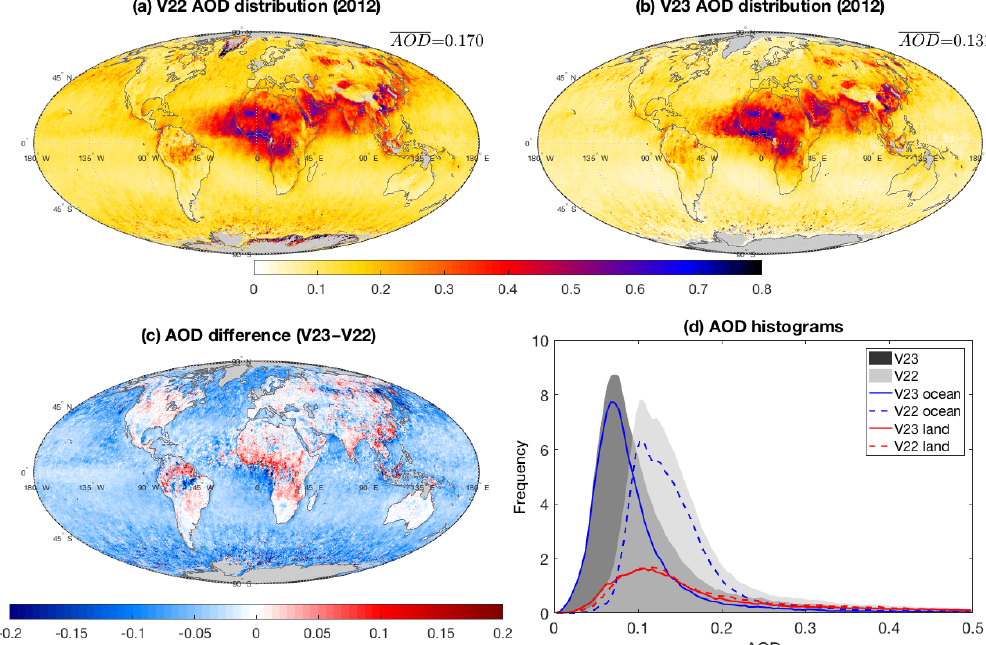
Figure 7. (a) Global distribution of AOD in 2012 from V22 retrievals gridded at 0.5 ◦ resolution. Panel (b) is the same as (a) but using V23 retrievals. (c) AOD difference between V23 and V22. (d) Histograms of gridded AODs: the dark grey shading shows V23 data, the light grey shading shows V22 data, and the solid lines show V23 retrievals over ocean (solid blue) and land (solid red), whereas the dashed lines show V22 retrievals over ocean (dashed blue) and land (dashed